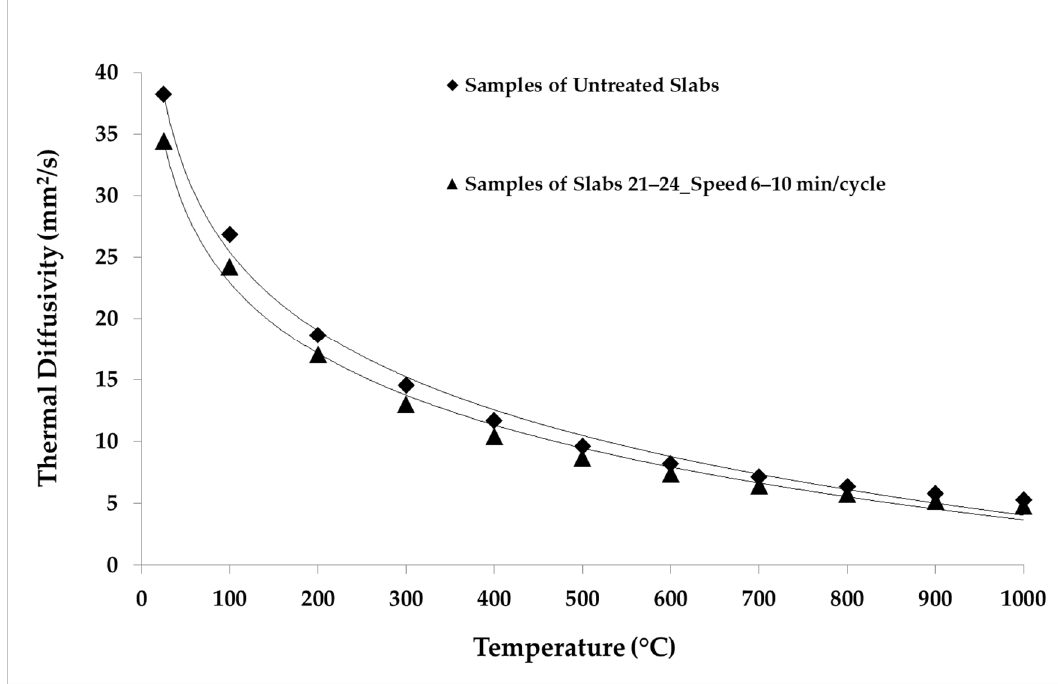
Figure 11. Thermal diffusivity values of untreated samples and samples aged in the temperature range 300–1000 °C.